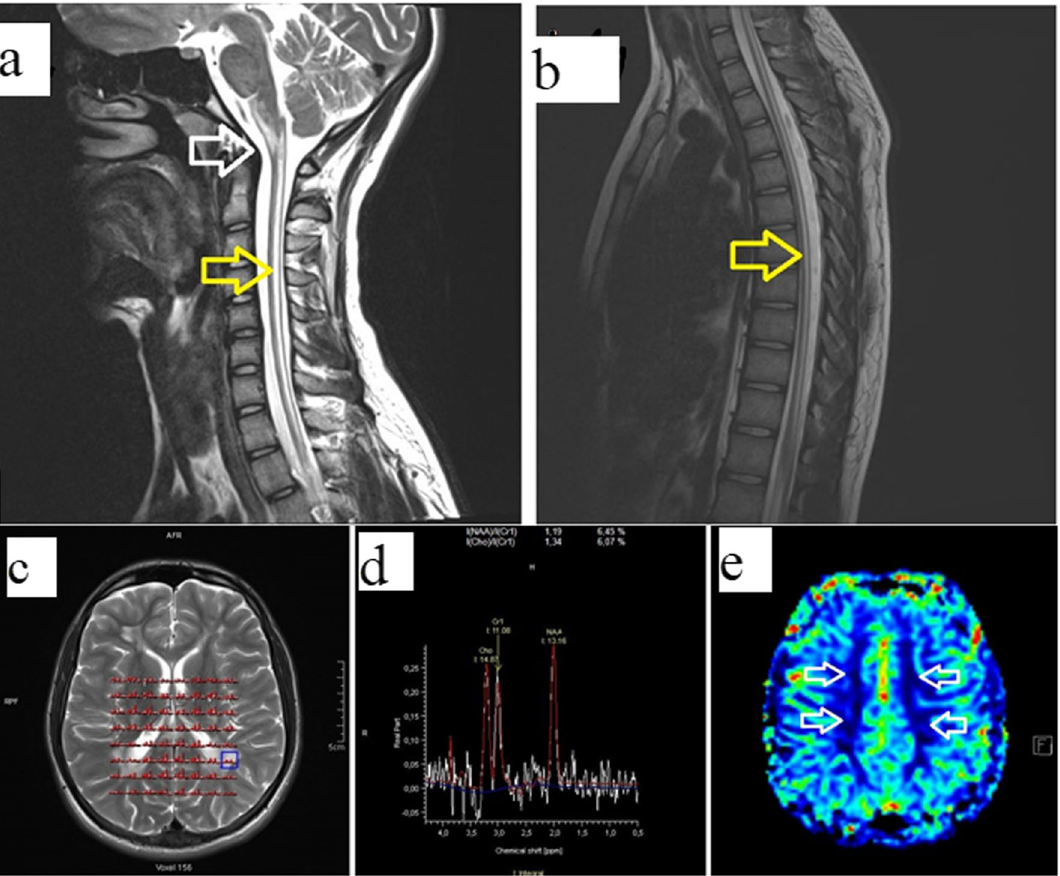
Fig. 3 Spinal MRI. a Sagittal T2 image of the cervical spinal cord: syrinx cavity (yellow arrow) and brain stem lesions are also seen (white arrow), b sagittal T2 image of the thoracic spinal cord: syrinx cavity (yellow arrow). Brain Spectroscopy imaging: c sample on white matter lesion (blue square), d Choline(Cho), Cretininine (cr1) and N-acetyl aspartate (NAA) metabolites with nearly normal values, e cerebral blood volume map of brain perfusion imaging showing decreased white matter